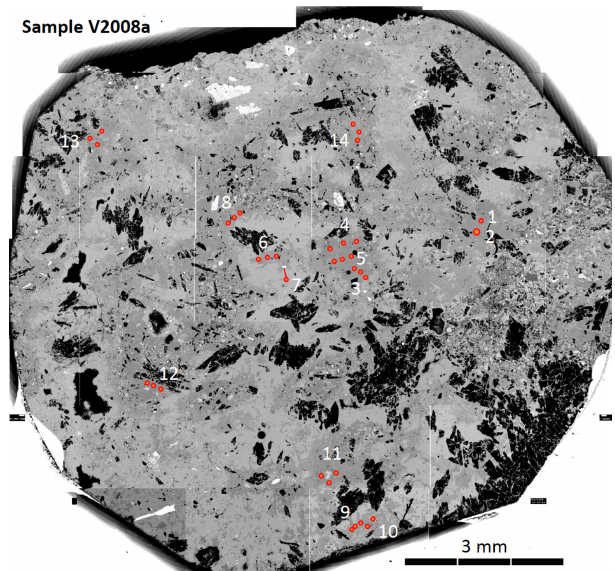
Figure 4. BSE mosaic image of sample V2008a: polished piece of the pseudomorph, prepared for irradiation, rich in buddingtonite (dark gray BSE contrast, compared to light gray BSE contrast of opal). Crystals with black BSE contrast are bertrandite, and crystals with white BSE contrast are alkali feldspar. Numbers refer to anal- ysis number in Table 1 (test runs 1 and 2 not marked), and red spots indicate laser-ablation spots. Three shots were used for one analysis except for analysis 7, a relict